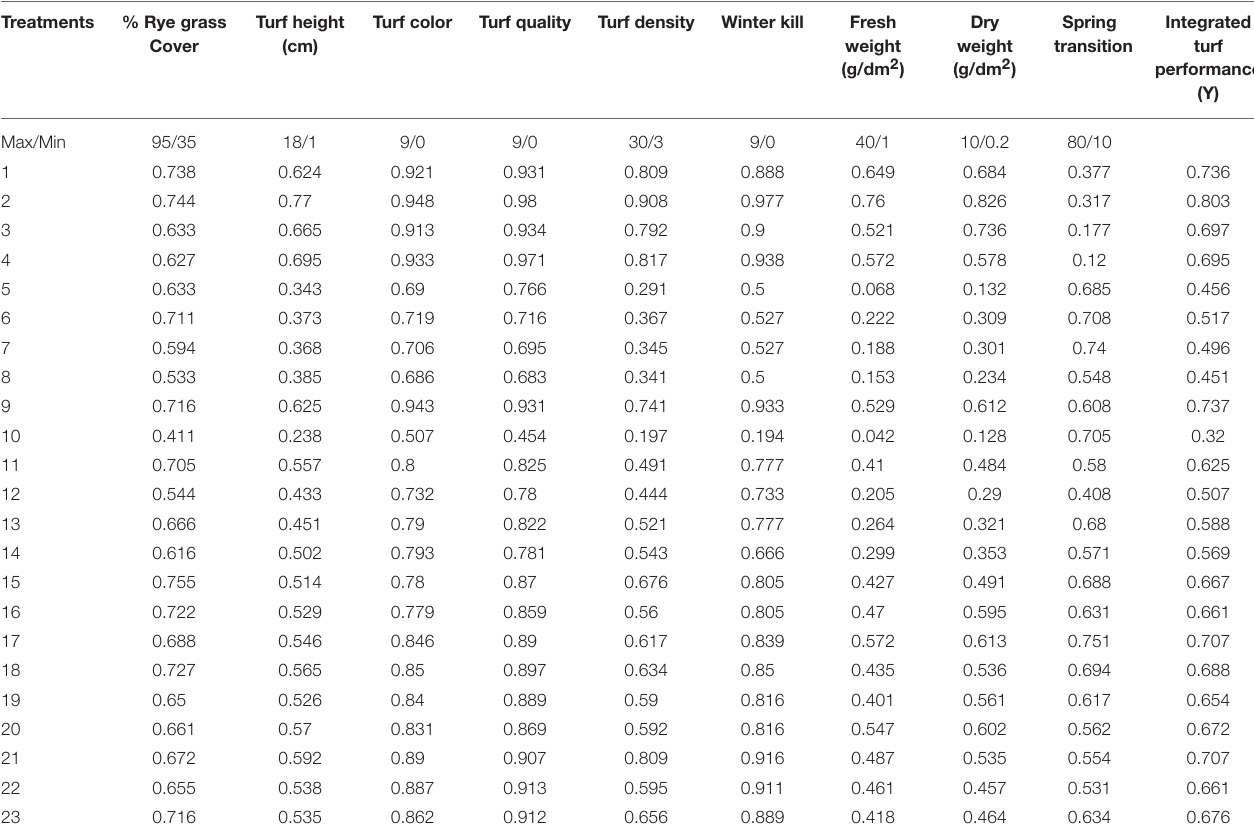
TABLE 8 | Transformed values of morphological parameters according to the central composite rotatable design and integrated turf performance (ITP) of overseeded perennial ryegrass on bermudagrass from 2015 to 2016. Treatments % Rye grass